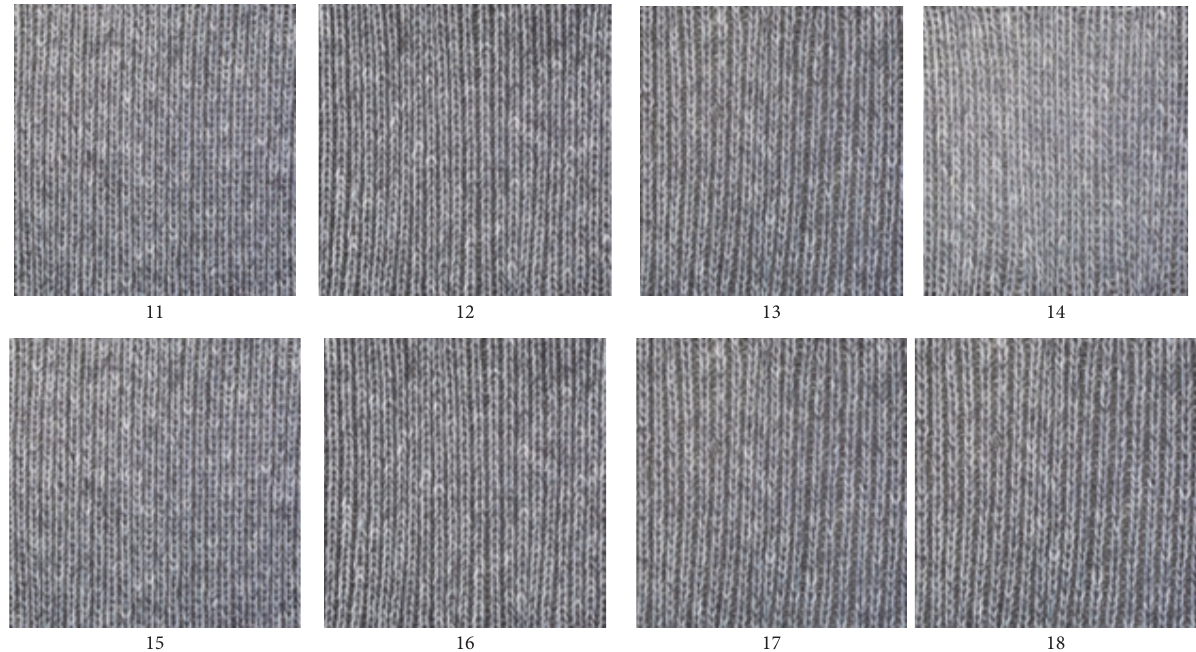
Figure 1: Rib 1 × 1 samples knitted at 8 stitch levels, starting from 11 to